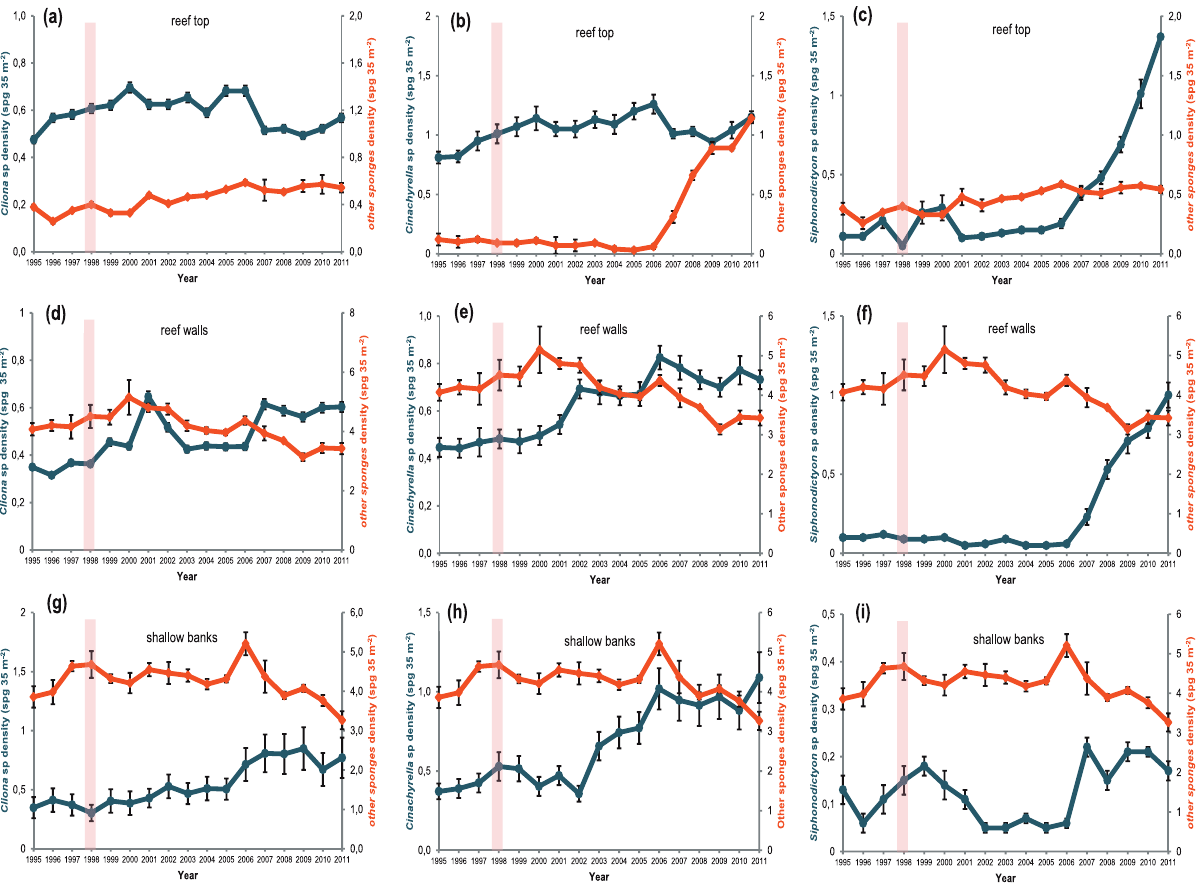
Figure 4. Changes in density of Cliona spp., Cinachyrella spp. and Siphonodictyon spp. recorded from the three contrasting reef habitats from Bahia, Brazil. Vertical bars represent the timing of the 1997–8 El Nin˜o event.